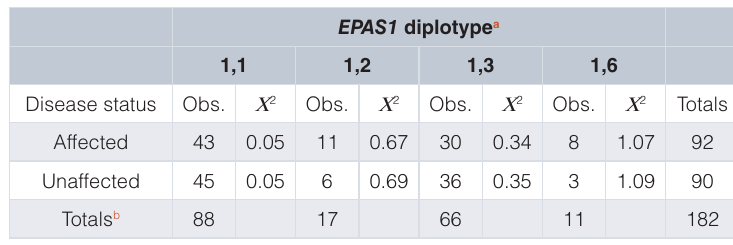
Table 3. Pearson’s chi-squared analysis of EPAS1 diplotypes among cases and controls.